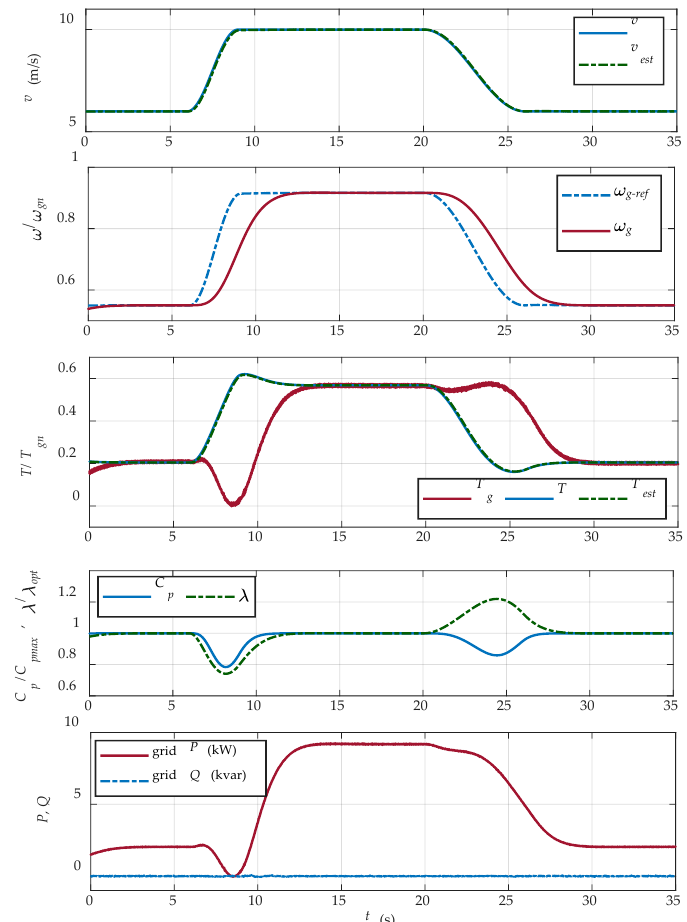
Figure 13. Plots of the WECS variables for a single coherent wind gust.